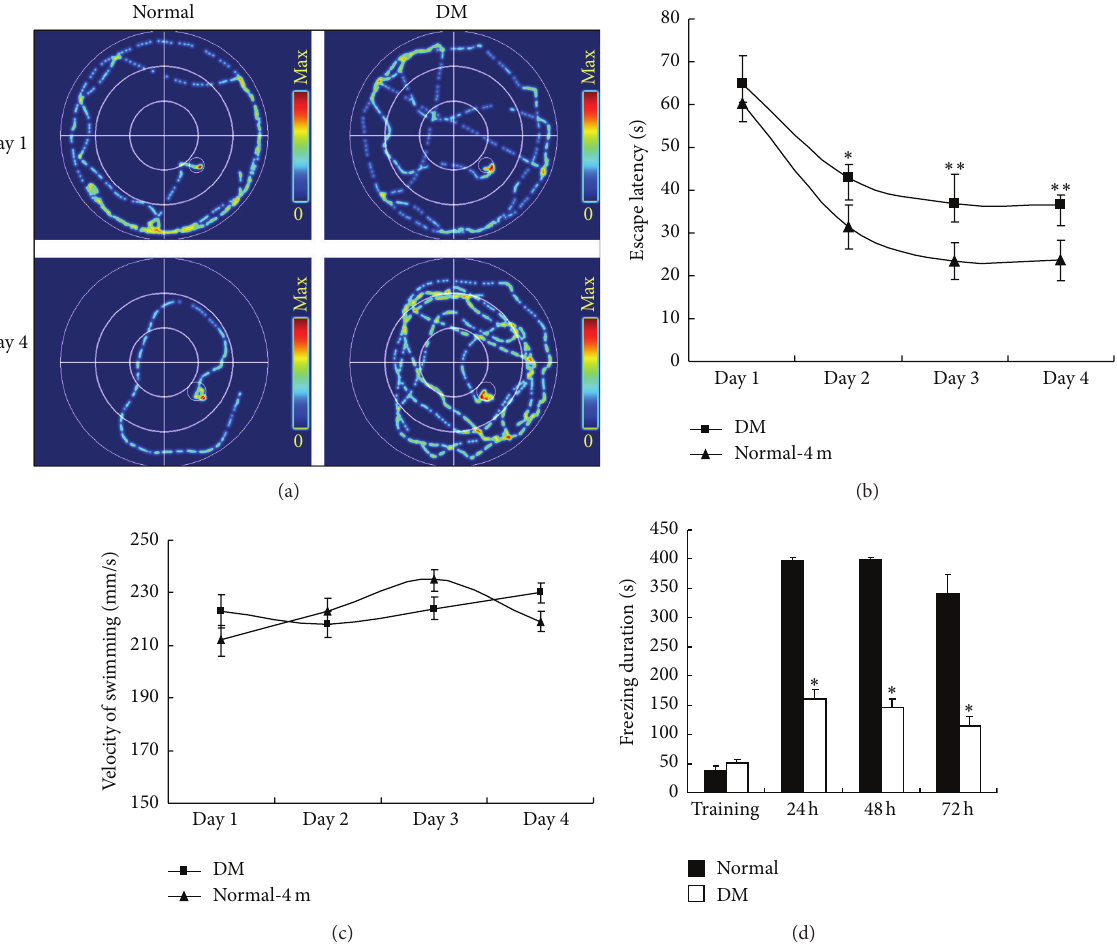
Figure 6: Evaluation of the cognition of diabetic rats at 4 months after STZ injection. (a) Representative traces by the Morris water maze. The performance of rats in the Morris water maze using hidden platform training for 4d was assessed based on (b) escape latency and (c) swimming velocity in the normal and DM groups. (d) Freezing duration was measured using inhibitory avoidance box. ∗ 𝑃 < 0.05 , significant difference compared with the age-matched control rats; ∗∗ 𝑃 < 0.01 , significant difference compared with the age-matched control rats; 𝑛 = 12